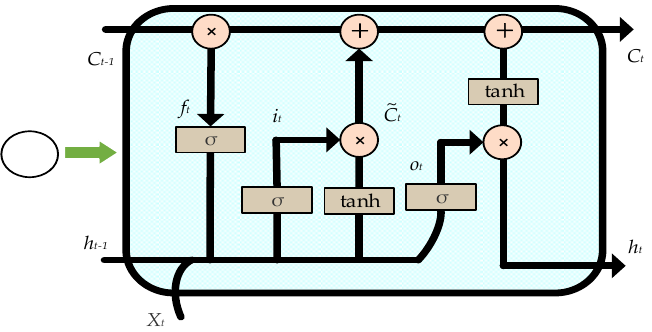
Figure 6. The structure of single LSTM-RNN memory cell.